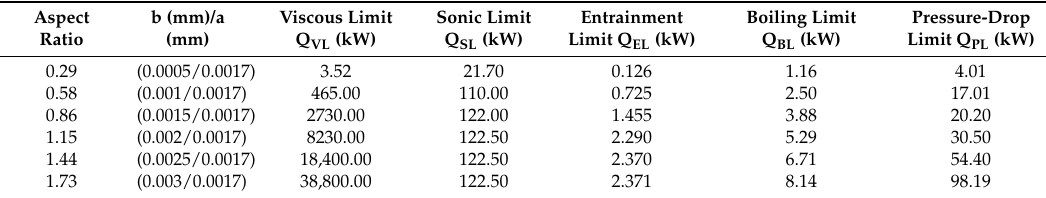
Table 3. Impact of the aspect ratio.